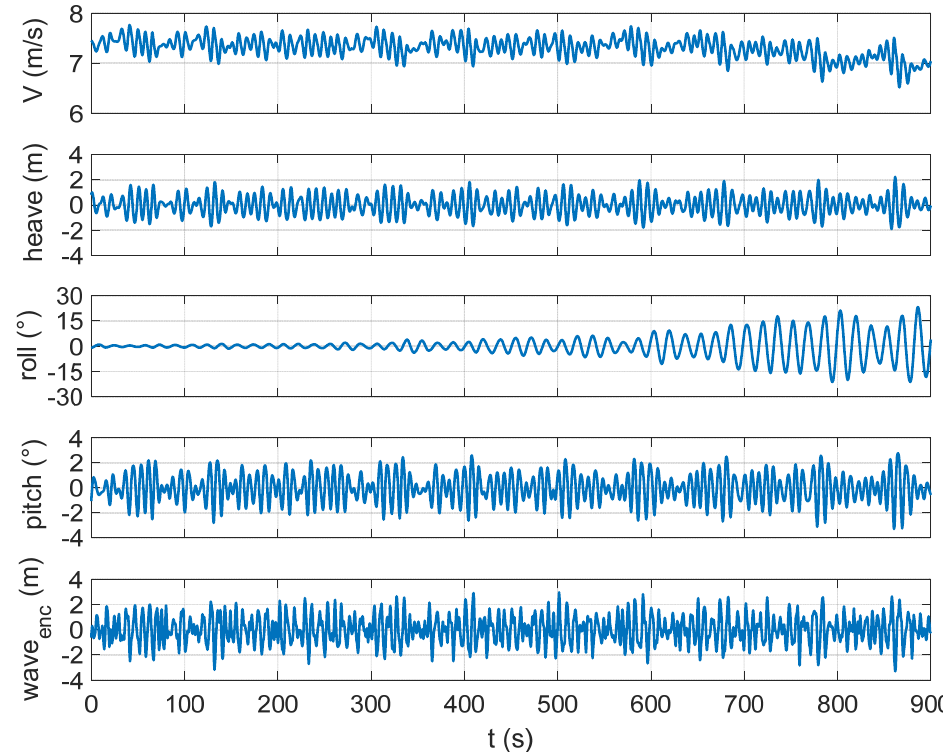
Figure 6. Time history of the ship dynamics in a head sea, Hs = 4.5 m Tz = 9.0 s: parametric roll Figure 6. Timehistoryoftheship dynamicsinaheadsea, Hs =4.5mTz=9.0 s: parametric rolldevelopment. development.